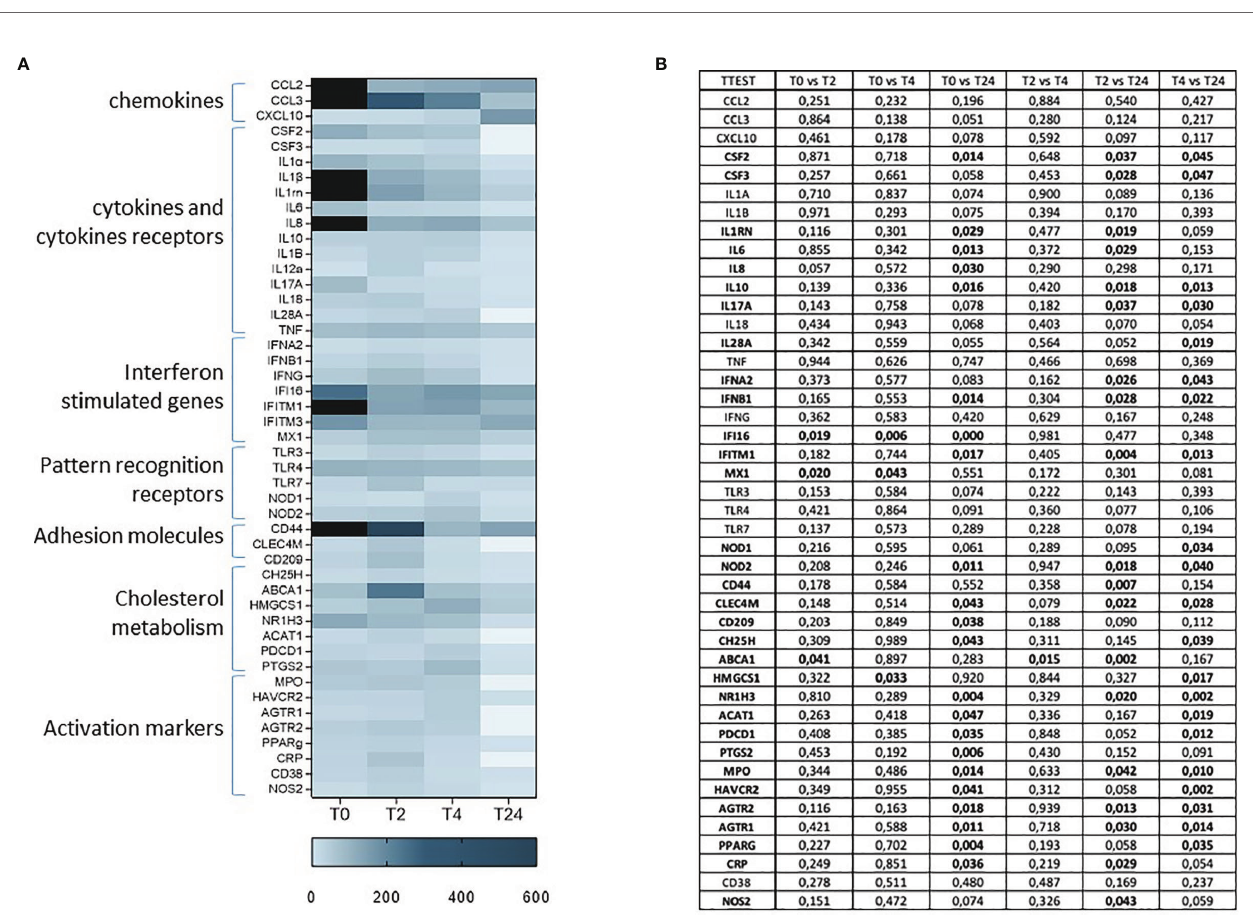
FIGURE 3 | mRNA expression of 74 genes involved in the in fl ammatory response at T0, T2, T4 and T24 upon SARS-CoV-2 speci fi c in-vitro stimulation of PBMCs (A) . Gene expression (nfold) is shown as a Colour scale from light to dark blue. Only the most relevant targets are shown in the table. Statistical signi fi cance obtained by multiple t Test analyses is reported in (B) . p ≤ 0.05 values are highlighted in